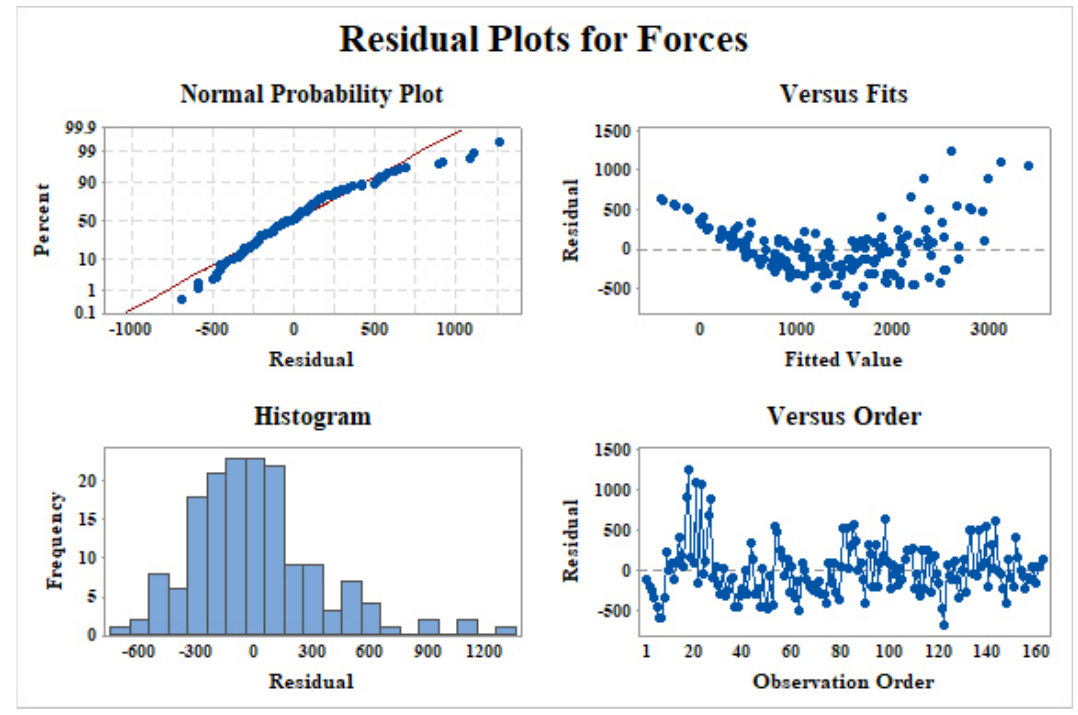
Figure 10. Residual plots for forces.